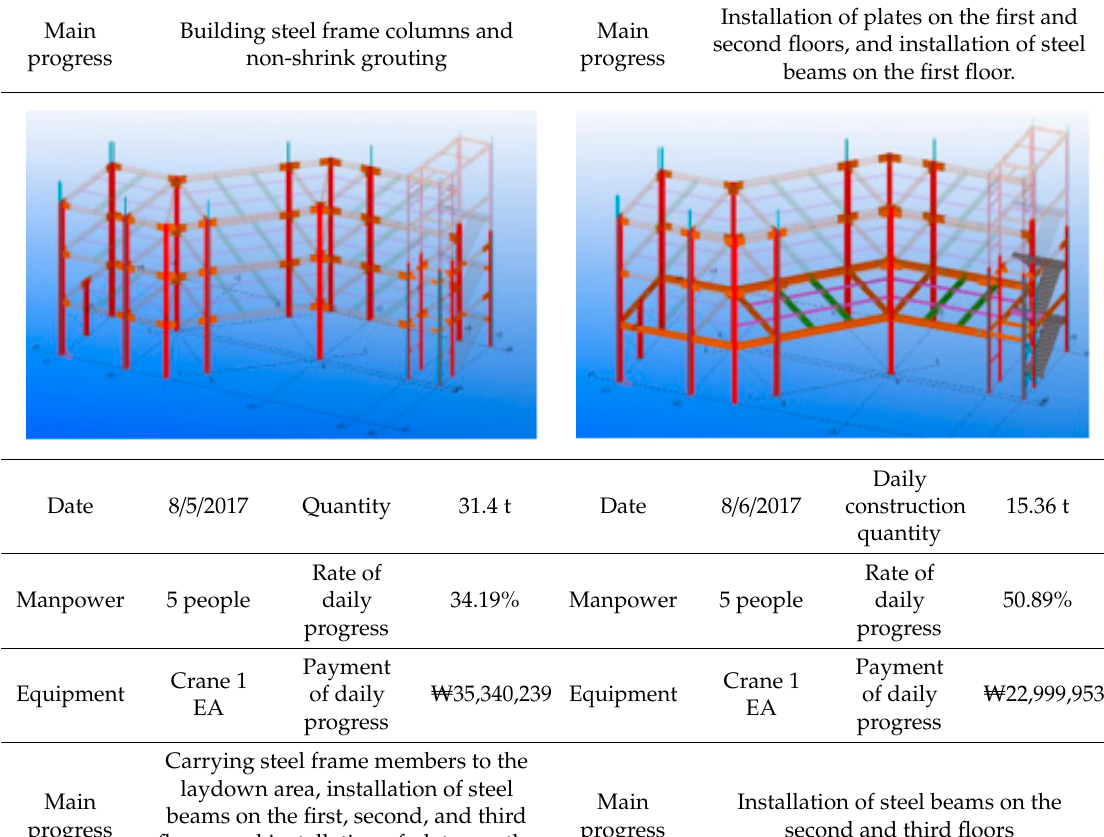
Table 10. Four- / five-dimensional (4D / 5D) model in terms of construction schedule. Main Building steel frame columns and progress non-shrink grouting